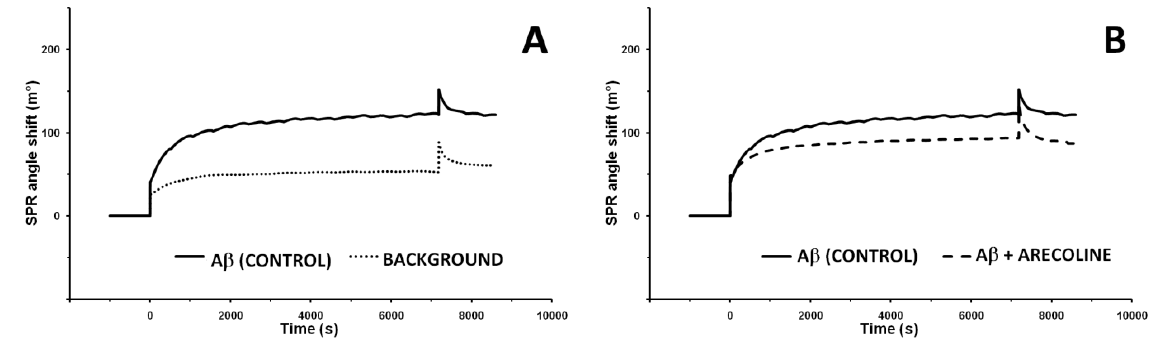
Figure 4. The representative SPR binding curves for Aβ of Aβ injected alone performed on SPR gold discs surface functionalized with: Aβ 40 probe (control) or with 11-MUA SAM treated with ethanolamine after activation with EDC/NHS (background); ( B–F ) Aggregations of Aβ presence of 1.0 mM of tested compound performed on a Aβ surface (For measurement conditions-see Experimental parts: 2.6 and